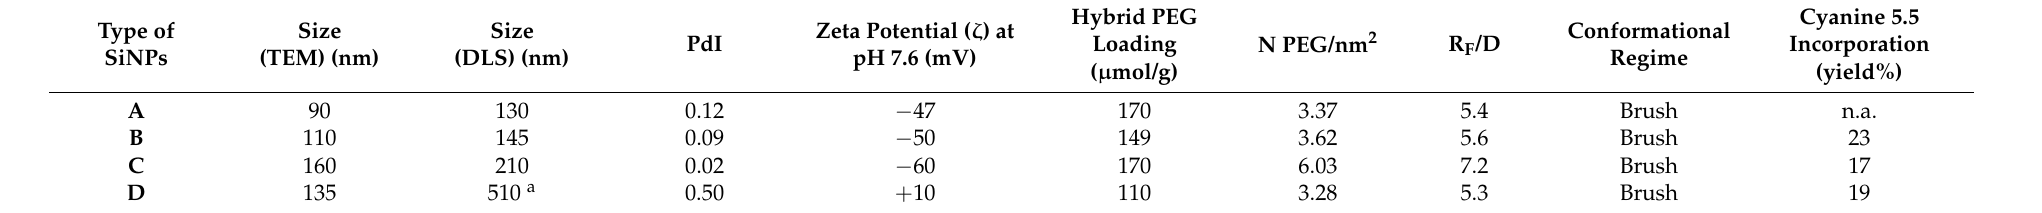
Table 1. Size (TEM and DLS), zeta potential ( ζ ), quantification of hybrid PEG 2 grafting, and fluorophore encapsulation of the different SiNP